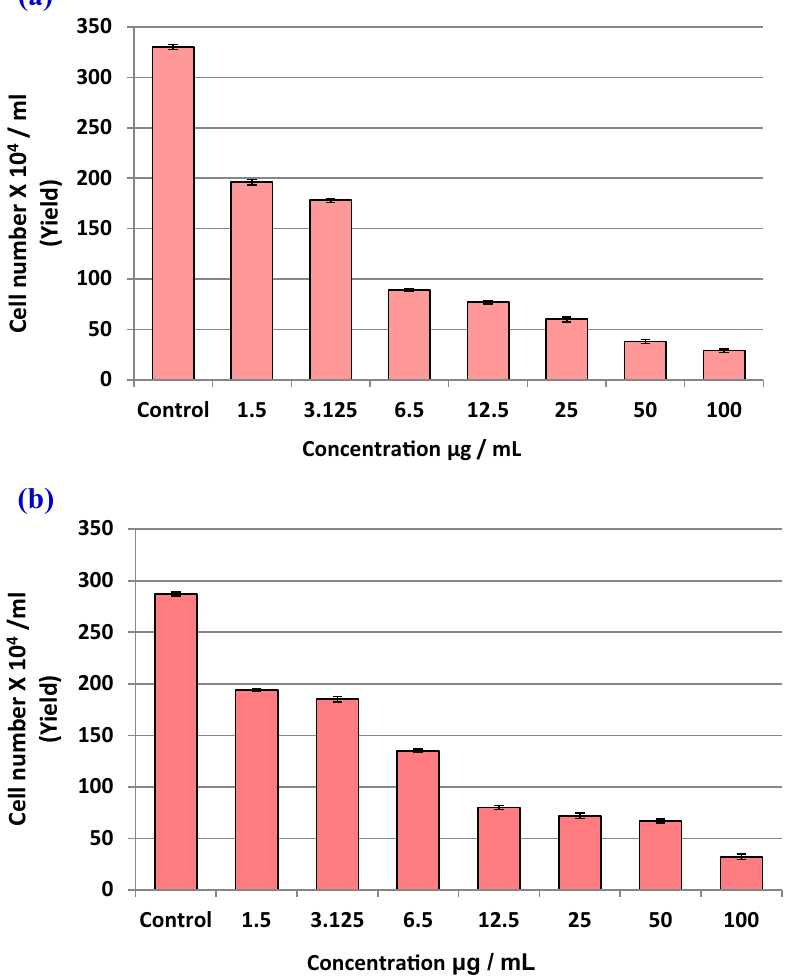
Figure 7. Yield of Chlorella vulgaris and Chlorella minutissima after 96 h exposure to different concentrations of OG-AgNPs ( a ) and ( b ),